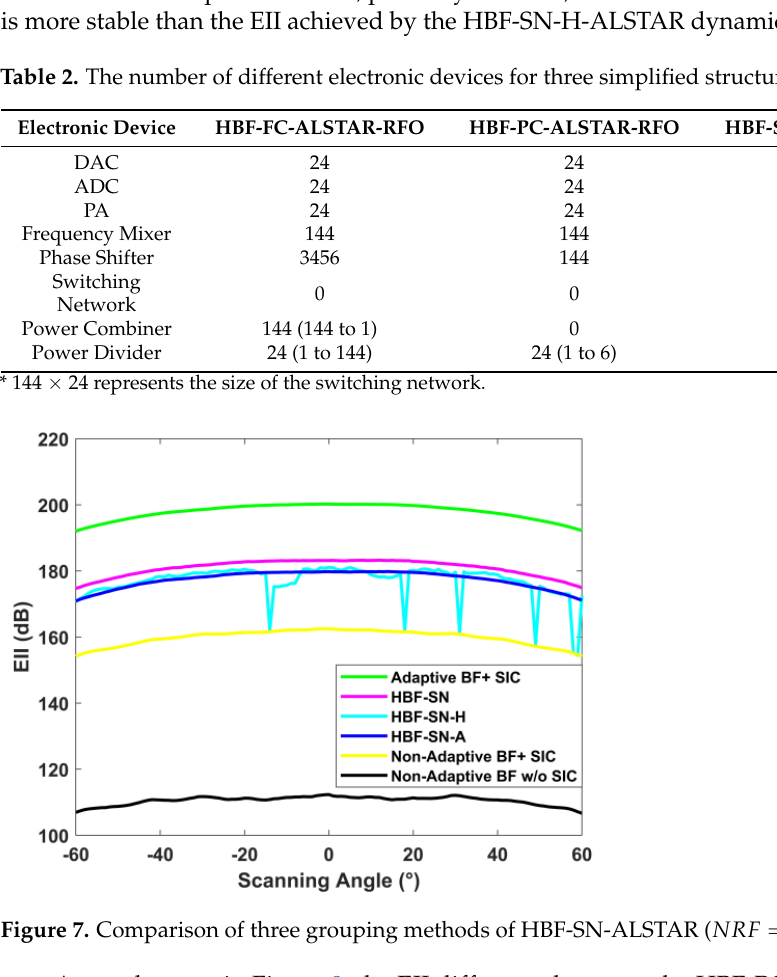
319 Figure 8. EII of three categories of simplified structures and FD-ALSTAR under different NRF con- 320 ditions 321 As can be seen in Figure 8, the EII difference between the HBF-PC-ALSTAR and the 322 HBF-SN-ALSTAR and FD-ALSTAR decreases with the increase in the number of RF links. 323 However, the EII difference between the HBF-PC-ALSTAR and FD-ALSTAR structures is 324 large, more than 30 dB, and the performance improvement is not significant. The HBF- 325 FC-ALSTAR reaches the local optimal solution at NRF=2 but its performance will decline 326 for NRF=3-16 to some extent. When NRF>16, the system performance will gradually ap- 327 proach that of the FD-ALSTAR with the increase in NRF, but its EII largely remains at the 328 optimal level of the three types of simplified structures. In HBF-SN-ALSTAR, the EII dif- 329 ference decreases rapidly with the increase in NRF, especially when NRF=16-17, when the 330 EII performance achieved is better than the MO-AltMin algorithm of HBF-FC-ALSTAR. 331 However, in the MO-AltMin algorithm selected for the FC structure in this paper, because 332